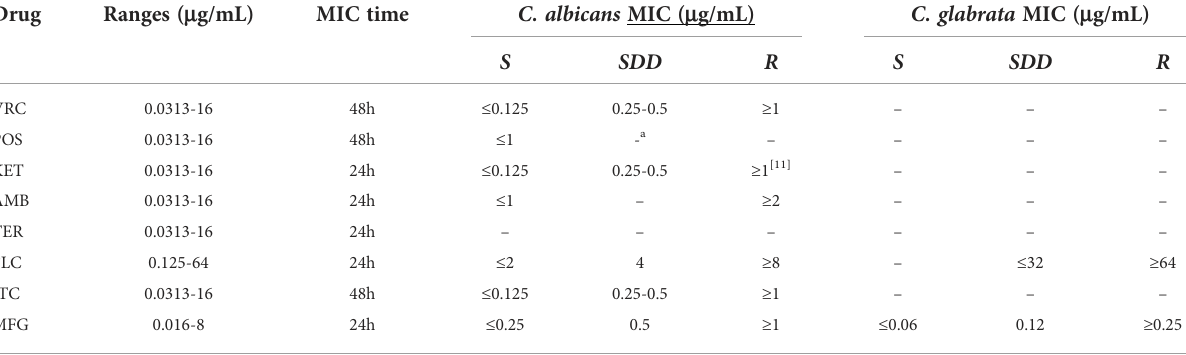
TABLE 1 Drug concentration range, time of MIC reading, and interpretive breakpoints for eight antifungal agents. Drug Ranges ( m